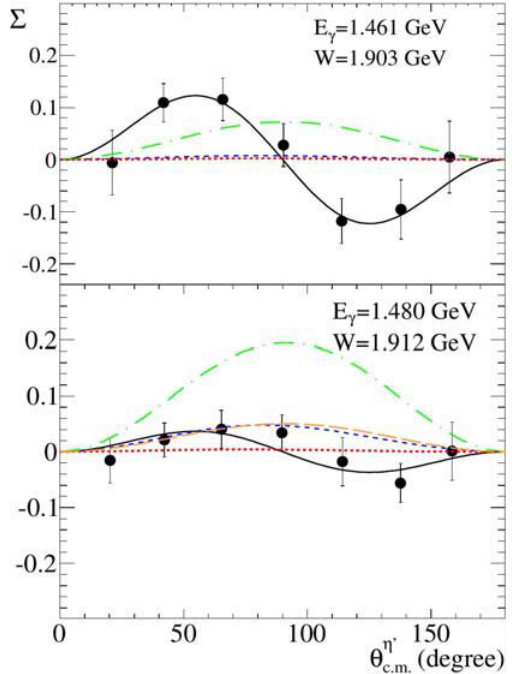
Figure 1. η (cid:2) beam asymmetry results from the GRAAL exper- iment. The colored lines are di ff erent theoretical calculations, references found in [1]. Figure taken from